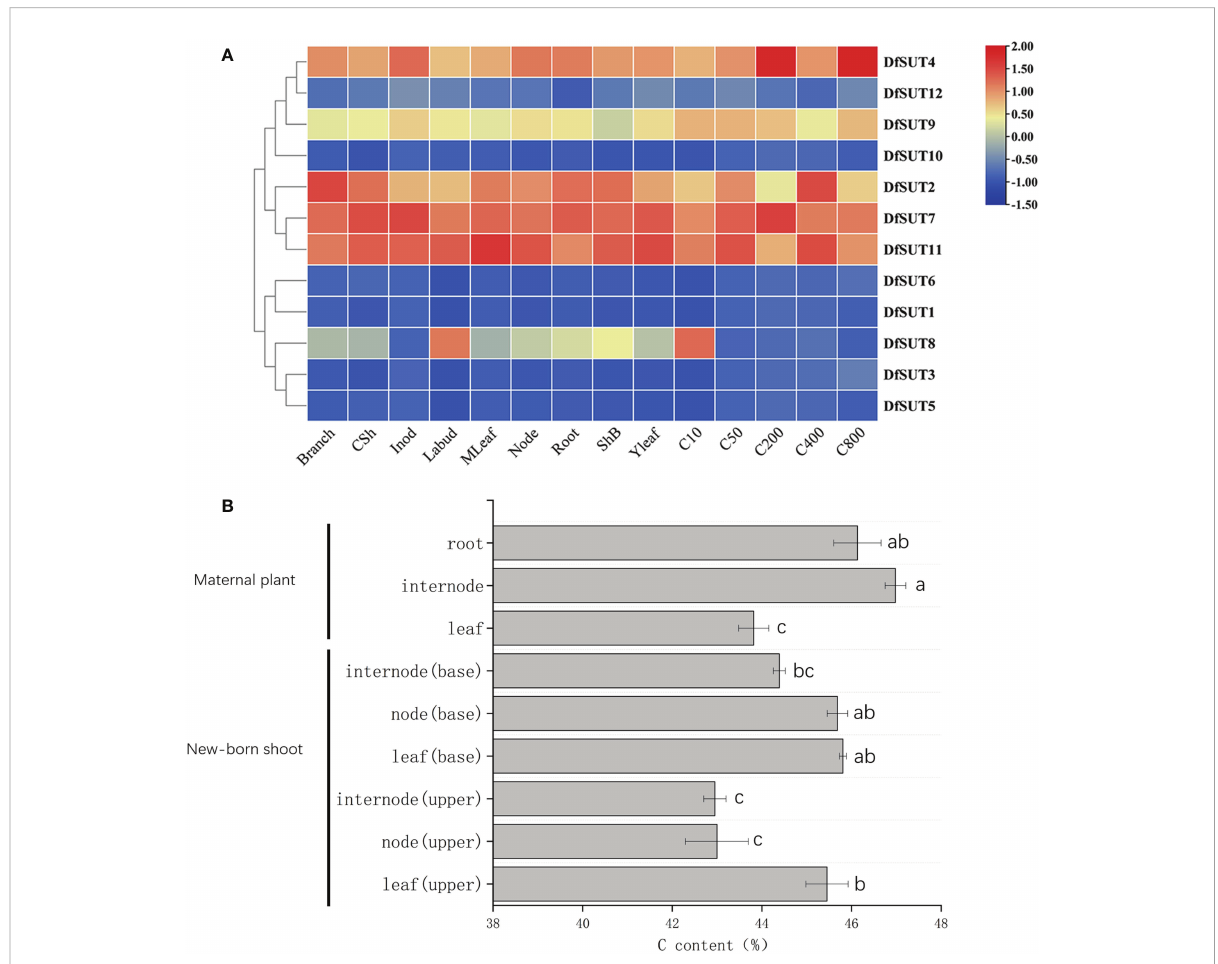
FIGURE 2 Analysis of transcriptome expression pro fi les of SUT and C content in different developmental phases/tissues of D. farinosus. (A) Transcriptome expression pro fi les of SUT at different developmental stages and various parts in D. farinosus . The red and blue colors correspond to the strong and weak expression of the genes, respectively. (B) C content in different developmental phases and tissues in D. farinosus. Data are detected as the mean ± SD from three independent experiments. The P -values of Student ’ s test for different developmental phases and tissues in D. farinosus are denoted with letters ( P <